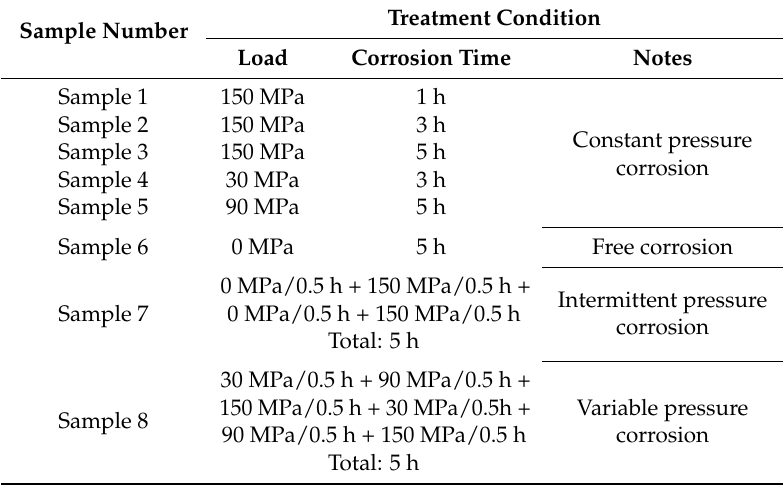
Figure 2. SEM image ( a ) and XRD patterns ( b ) of the original copper mold spray casted Mg 62.9 Zn 32.3 Ca 4.8 alloy.